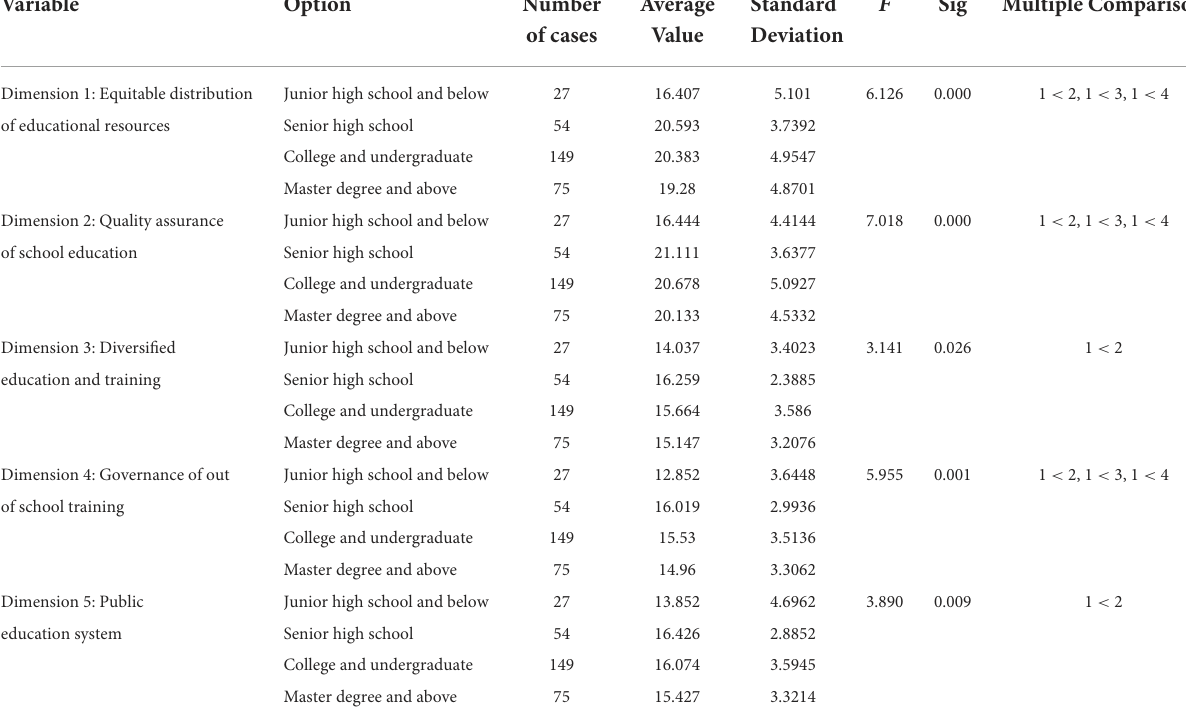
TABLE 12 Analysis of differences in academic qualifications of data from various dimensions.